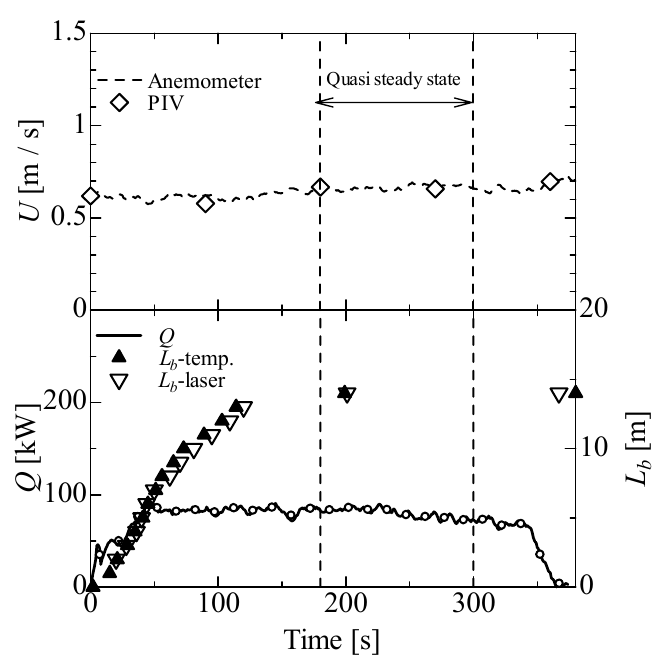
Fig. 2 Time curves of the heat release rate Q measured by electronic balance, ventilation velocity U measured by anemometer and PIV method, and backlayering distance L b measured by temperature distribution and laser beam methods, in the case of a burning area of A f = 0.079 m 2